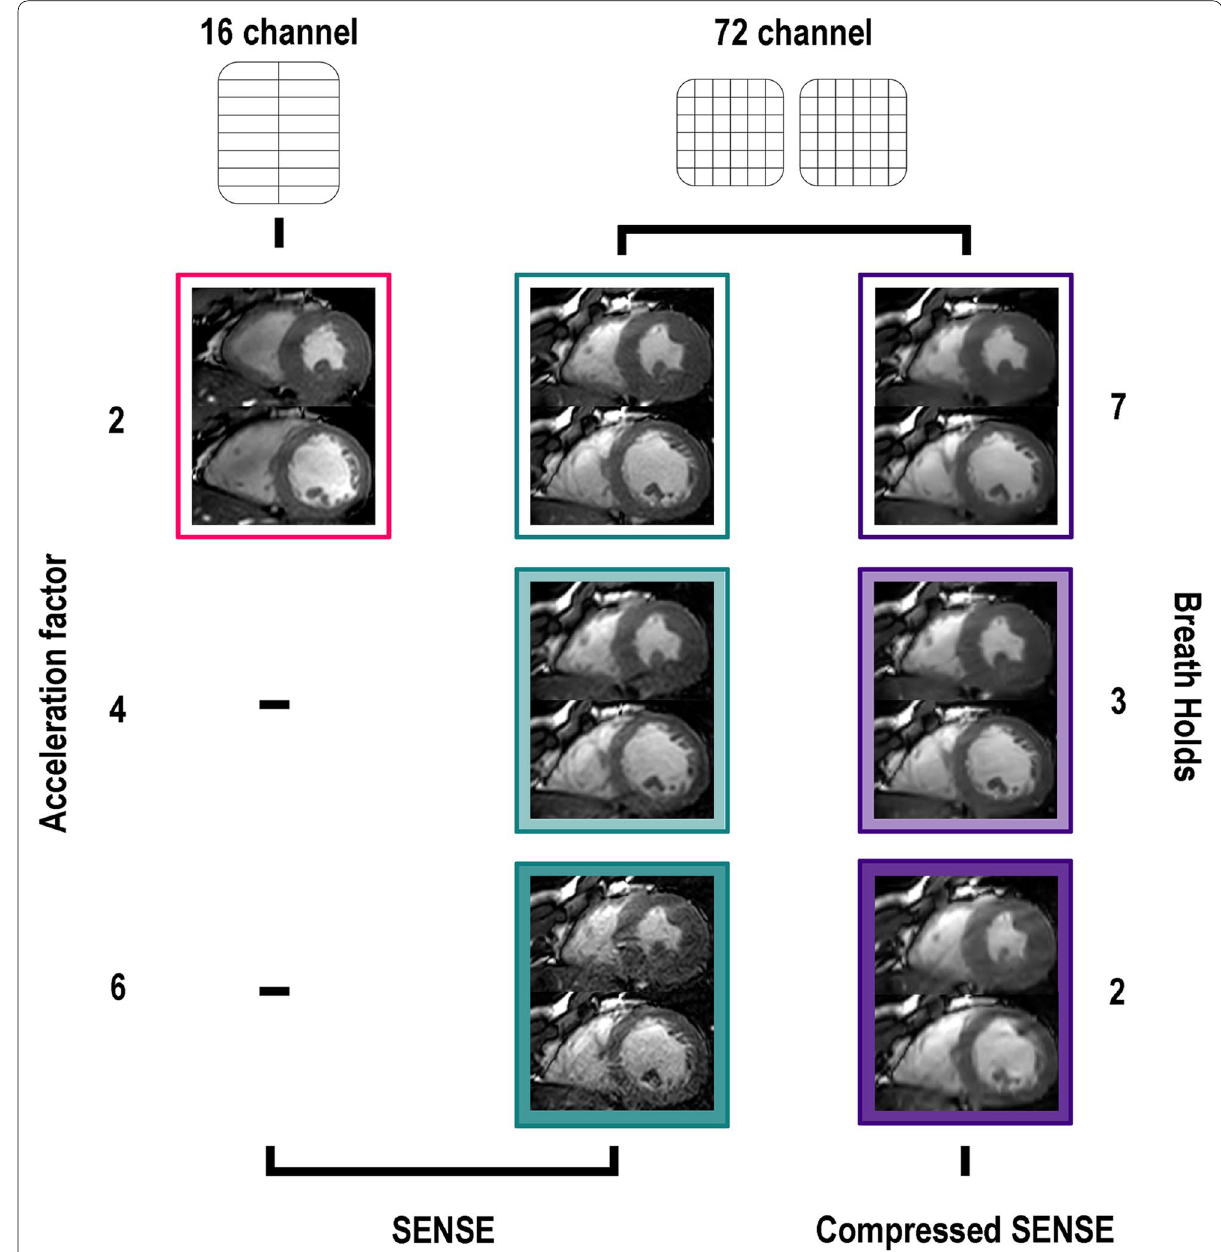
Fig. 2 Mid-ventricular balanced steady-state free precession short-axial images of a male participant during end-systole and end-diastole. The reference SENSE-2 scan acquired with the vendor-supplied 16-channel receiver array is outlined in red. Scans acquired with the new 72-channel receiver array are outlined in green for SENSE and purple for